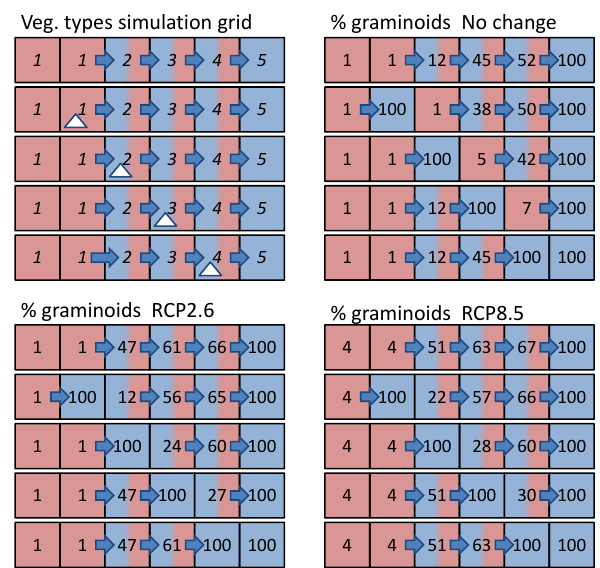
Figure 7. Results of thaw pond simulations: simulation settings (top left panel) in which vegetation types (numbers), initial wa- ter flows (arrows) and permafrost collapse sites are indicated. The other grids show the percentage of graminoids in total vascular plant biomass during the summers of 2065–2074 and the altered water flows for “No change”, RCP2.6 and RCP8.5 climate scenarios. Red cells: shrub-dominated, blue cells: graminoid-dominated, both blue and red cells: mixed vegetation.